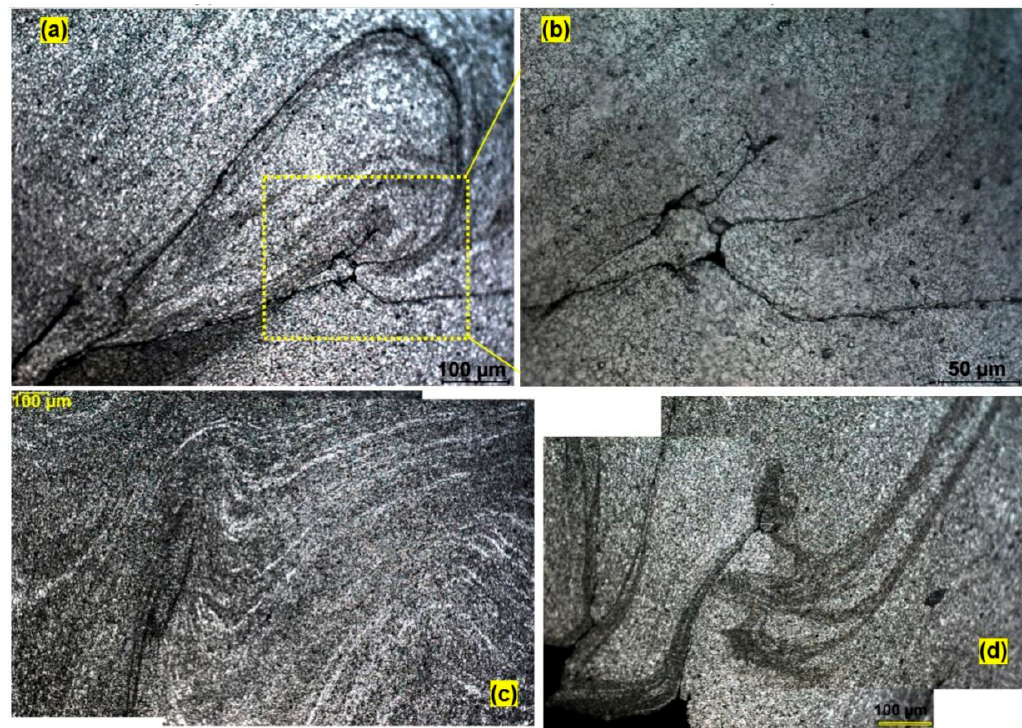
Figure 7. Microflows, tangled in different region of the cascade flow region of the SZ (Reagent C). ( a ) swirling line (region d in Figure 5), ( b ) higher magnification of ( a ); hair-line micro-crack, ( c ) magnified finger pattern and the wavy flow lines (region c in Figure 5), and ( d ) hook line flow at the jagged edge of the tunnel void (region b in Figure 5).